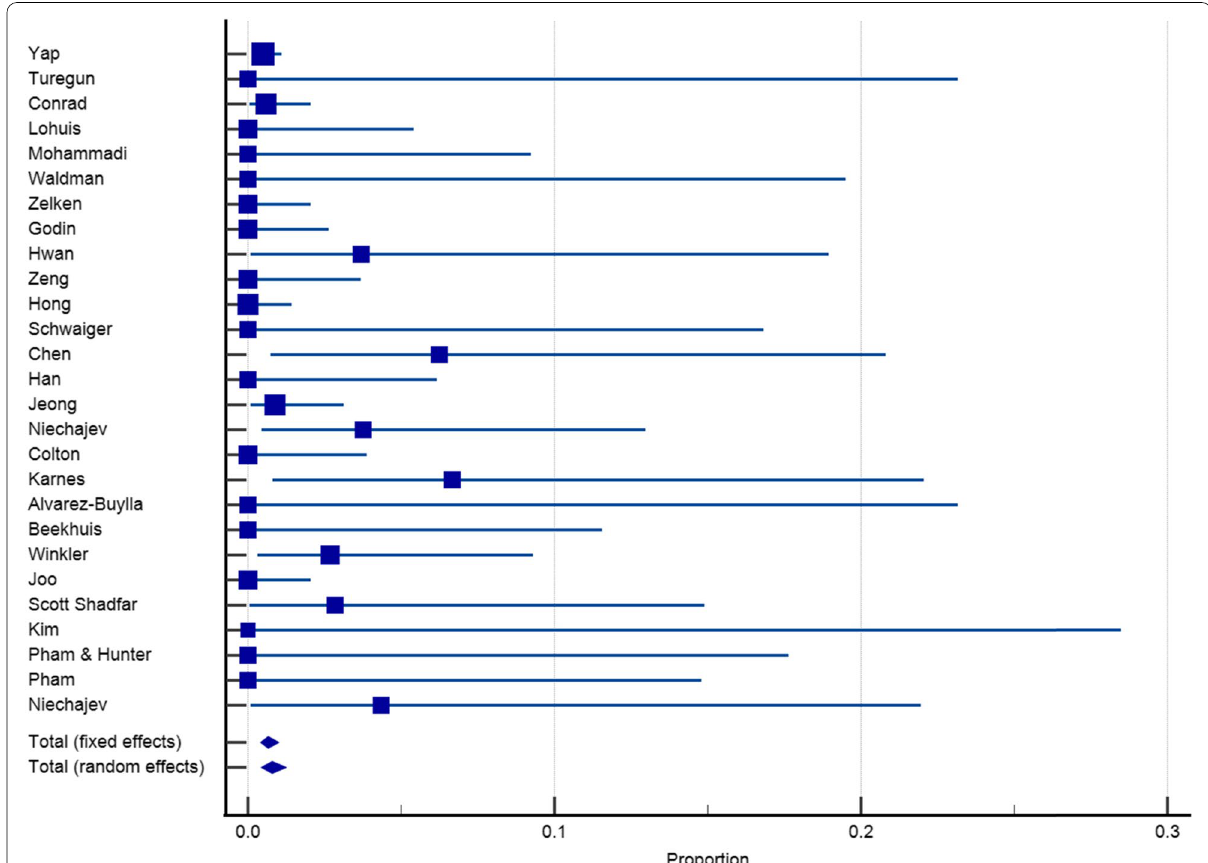
Fig. 5 Extrusion rates reported for synthetic materials in both fixed and random-effects